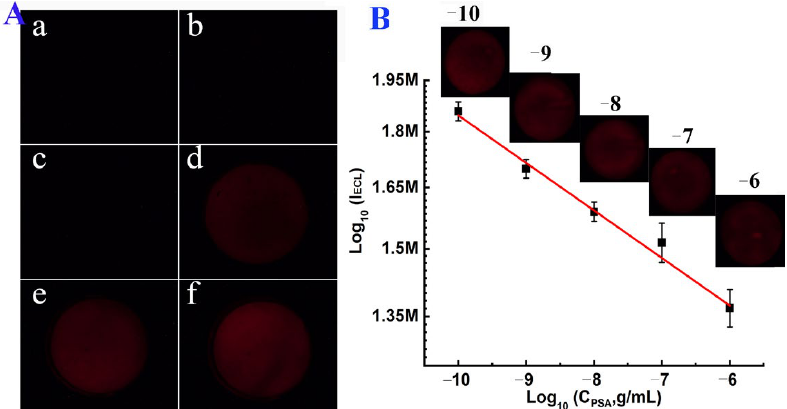
Figure 5. ( A ) ECL images obtained at bare (cathode)-bare (anode) GP BPE (BPE-1, a and b), bare (cathode)-Au-modified (anode) GP BPE (BPE-2, c and d), and Au-modified (cathode)-Au-modified (anode) GP BPE (BPE-3, e and f). The voltage applied in a, c, e was 3.0 V. The voltage applied in b, d, and f was 3.5 V. Images were obtained after applying voltages for 110 s. ( B ) Calibration curve for PSA detection. The deposition time of Au in the second process was 100 s. The concentration of PSA was 10 −10 , 10 −9 , 10 −8 , 10 −7 , and 10 −6 g/mL.